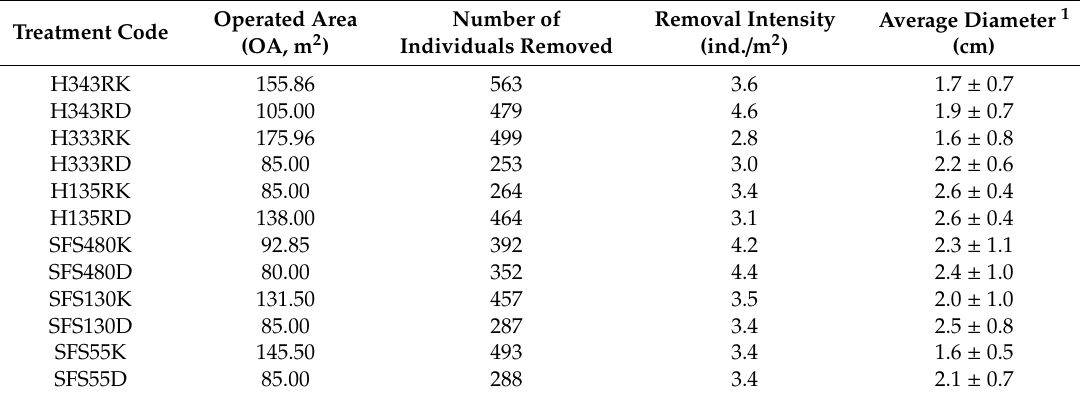
Table 3. Descriptive statistics of operational